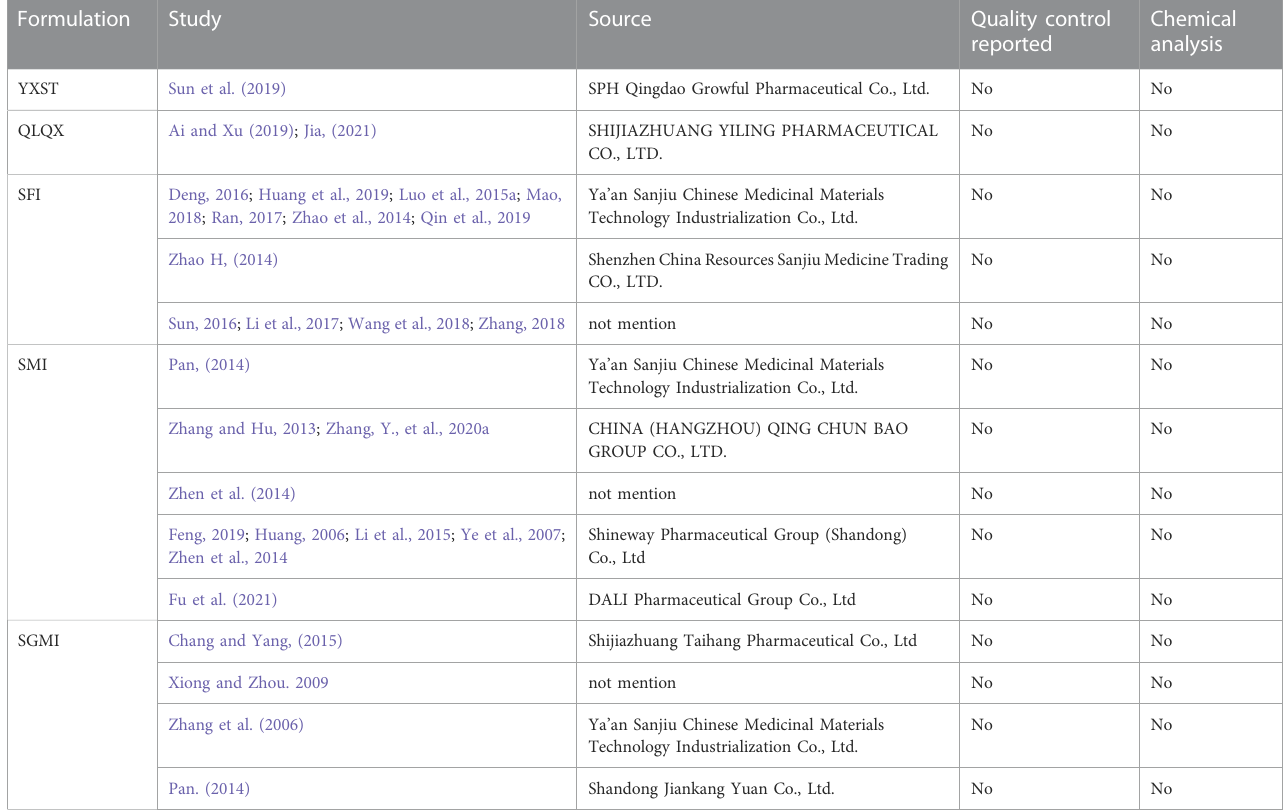
TABLE 3 The source, quality control and chemical analysis of fi ve ginseng-containing TCM.